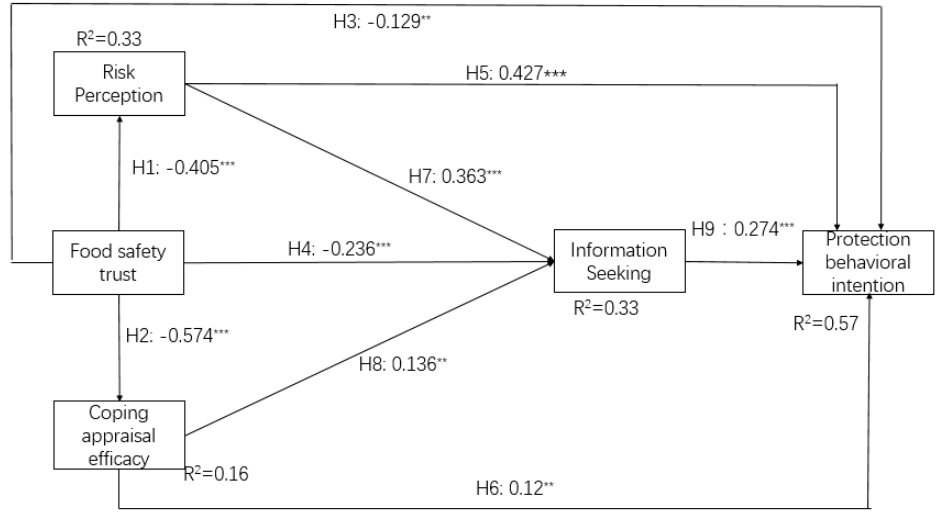
Figure 2. Results of the full analysis. Note: ** p < 0.01, and *** p < 0.001.